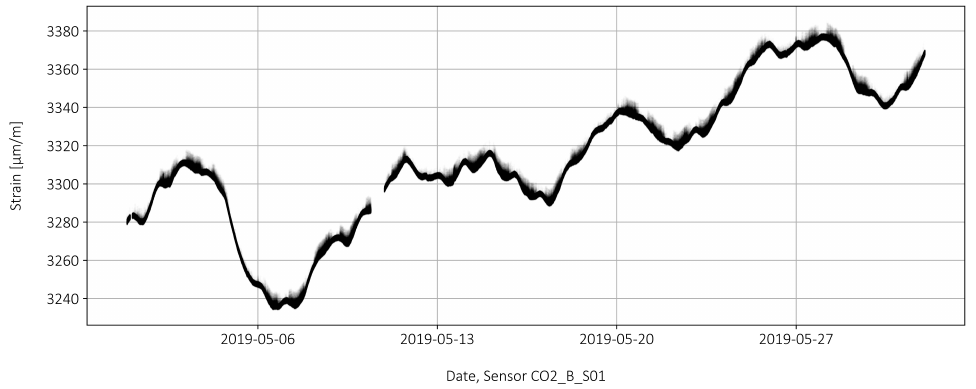
Figure 4. The raw strains measured at a single sensor over a period of one